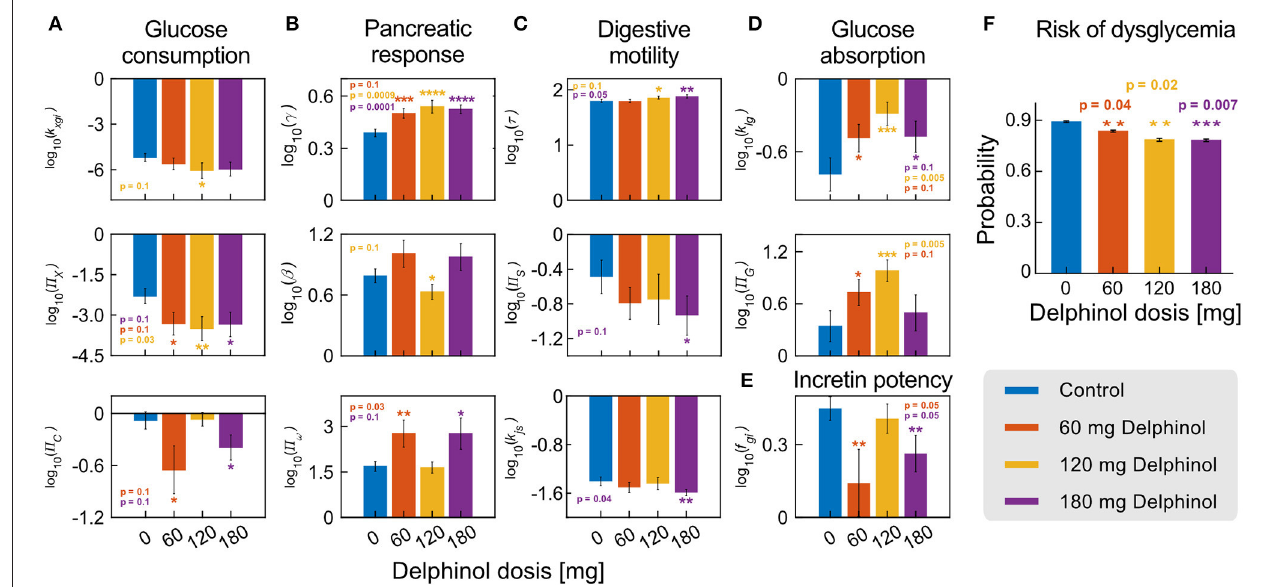
FIGURE 5 | Delphinol ® has a dose-dependent effect on different subsystems involved in G-I dynamics. (A–E) Comparison of the values of significantly varying parameters/NDNs between subjects in control conditions (no Delphinol ® , blue bars) and treated with 60 mg (orange bars), 120 mg (yellow bars), and 180 mg (purple bars) Delphinol ® prior to an OGTT. p -values are reported for the pairwise t-test comparison of the means of each treatment group with the control group. (F) Risk probabilities of dysglycemic (non-healthy) status calculated using the logistic model. The general risk of non-health status decreases with Delphinol ® treatment in a dose-dependent way. Reported values are average probabilities with errors and p -values of the difference between each dose and the control group. In the figure, the number of asterisks denotes levels of significance of the difference with the control experiment; * p ≤ 0.1, ** p ≤ 0.05, *** p ≤ 0.01, **** p ≤ 0.001.